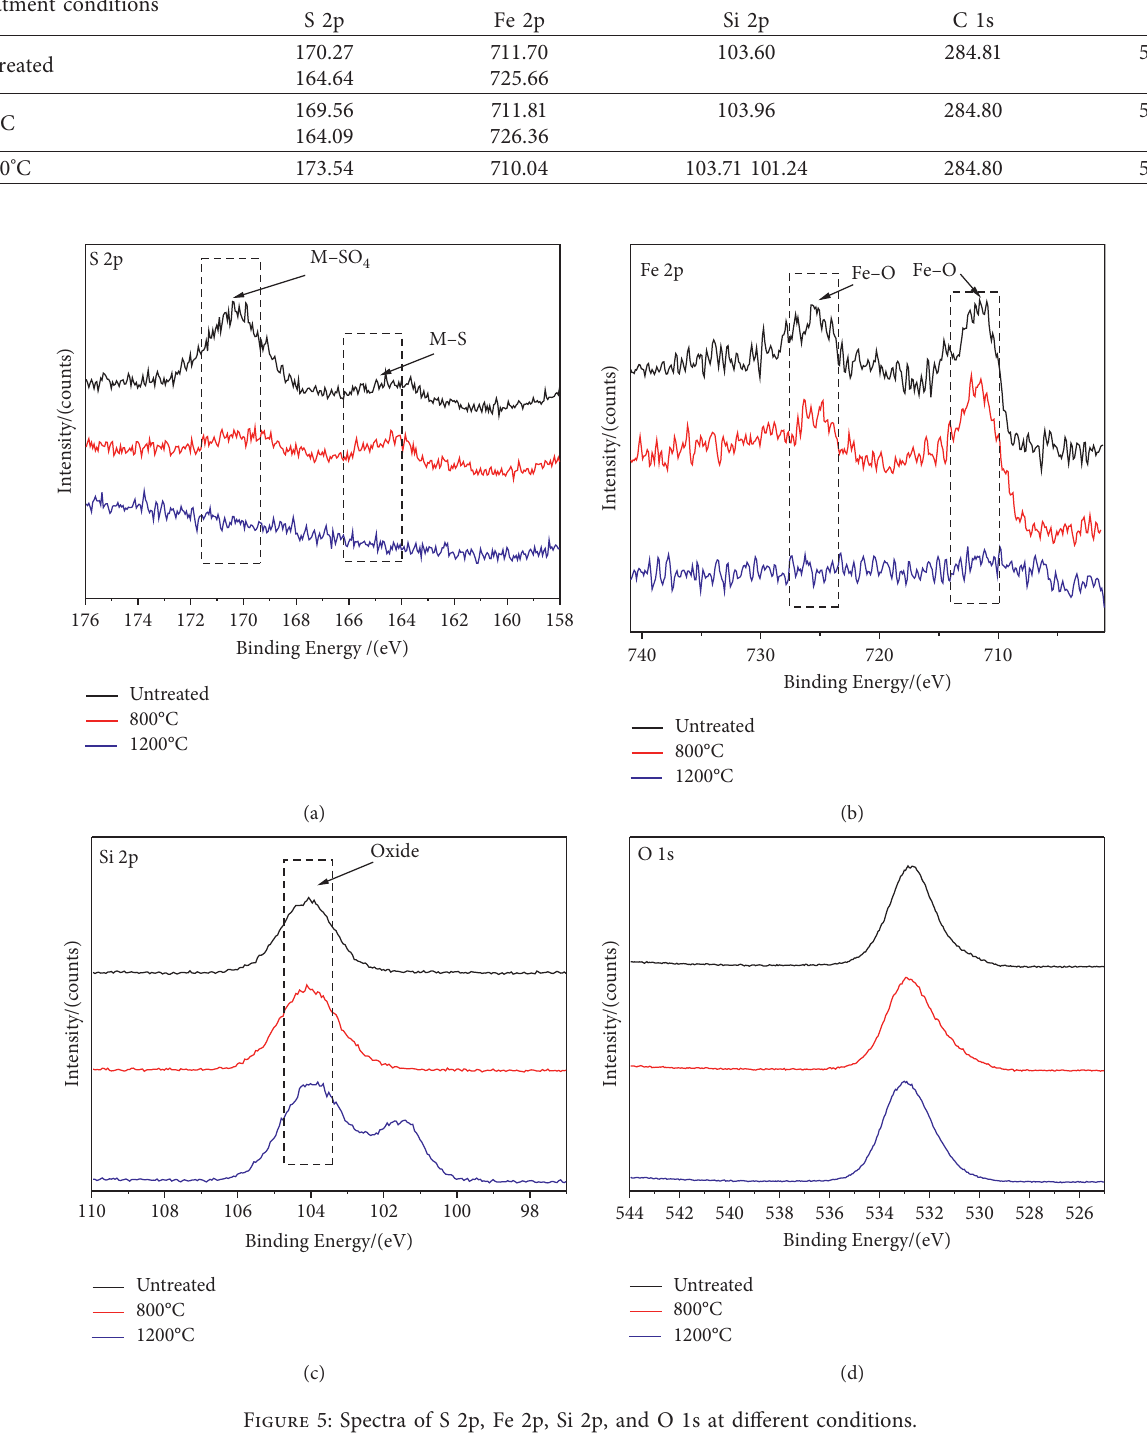
Table 6: Binding energy of the inner-layer electrons of the main elements on the sample surface at different conditions. Treatment